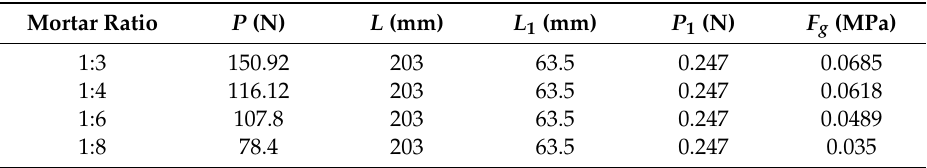
Table 4. Brick masonry bond strength.